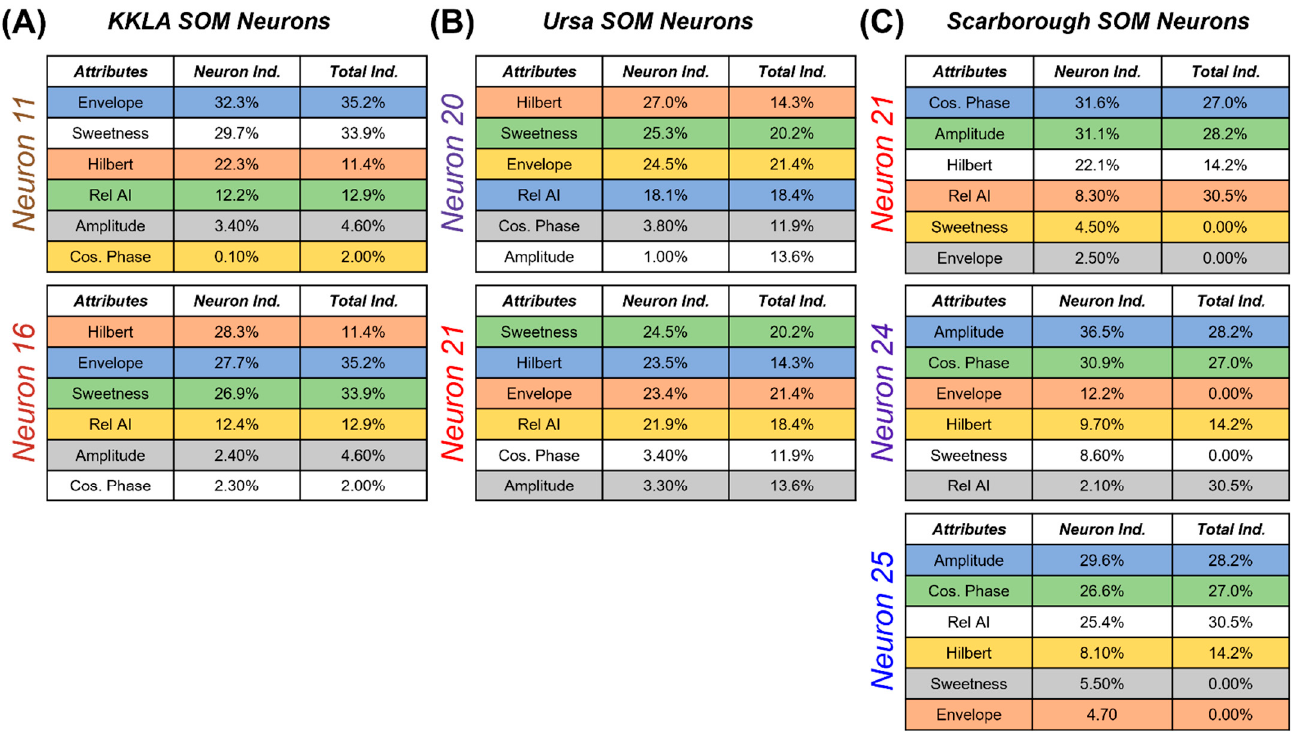
Figure 14. Neuron clustering results from ( A ) the KK/LA SOM, ( B ) the Ursa SOM, and ( C ) the Scarborough SOM.